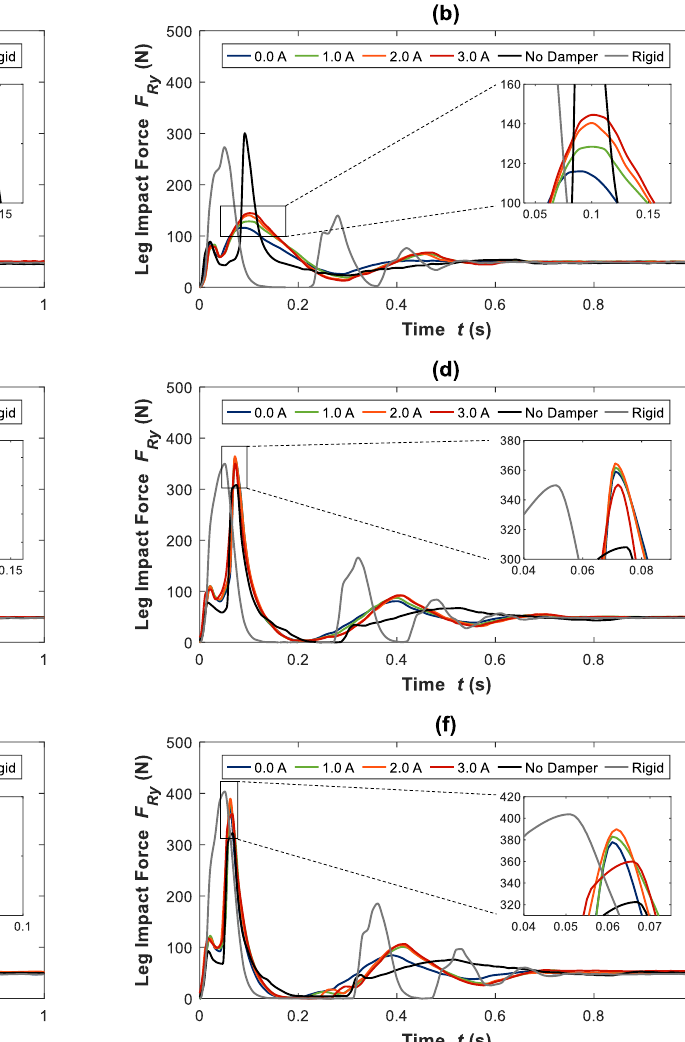
Figure 8. Leg impact force for impact tests with a 4.60 kg total mass for drop heights of ( a ) 100 mm,